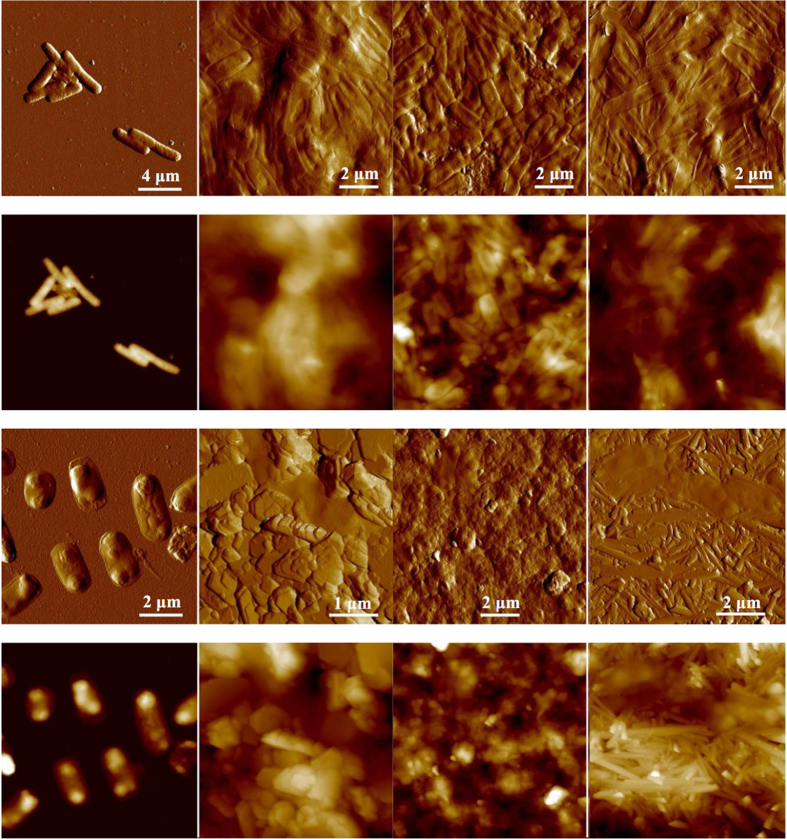
AFM peak force error and height images of E. coli biofilm formed on coverslips (the first column), kaolinite (the second column), montmorillonite (the third column) and goethite (the fourth column) surfaces after 2 days in M9 (the upper two rows) and LB medium (the lower two rows).